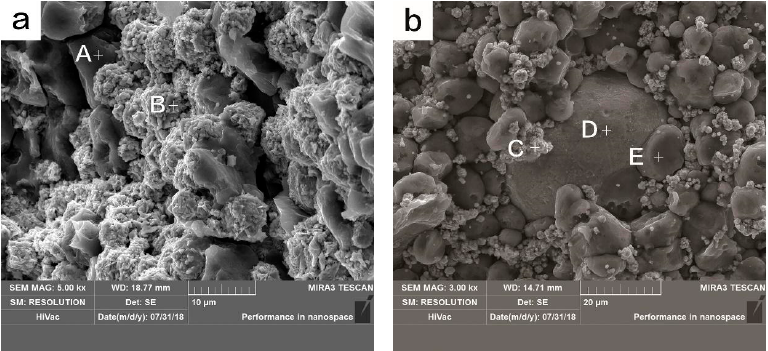
Figure 4. The SEM images of ( a ) Ni-Al RSCL and ( b ) Cu-Ni-Al RSCL. Materials 2018 , 11 , x FOR PEER REVIEW